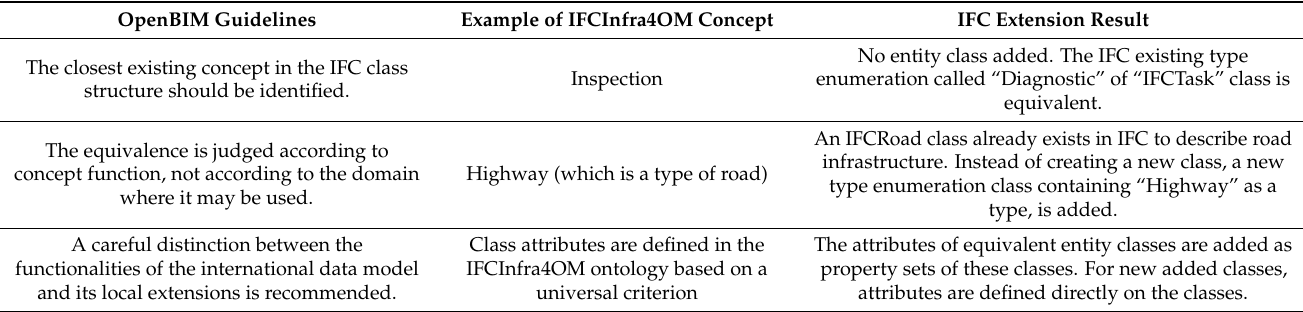
Table 8. BuildingSmart guidelines application approach to validate the IFC